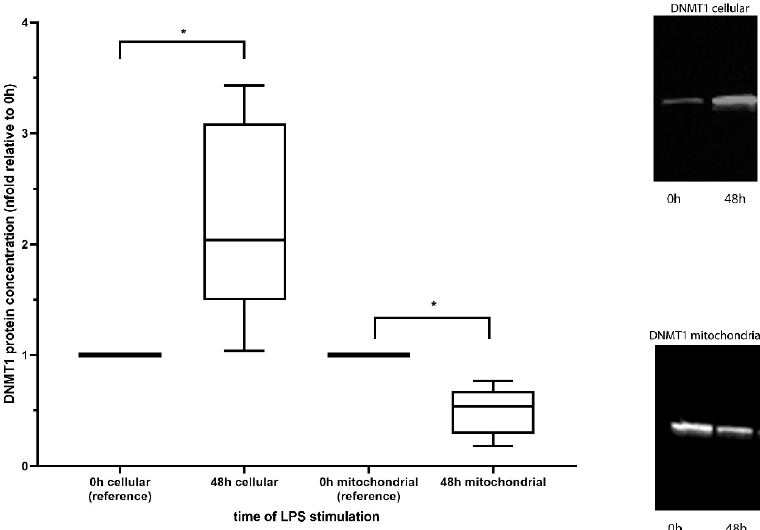
Figure 2. DNMT1 protein measurement. Although cellular expression of DNMT1 increased after LPS stimulation, the amount of this protein reaching the mitochondria decreased (*: p < 0.05).